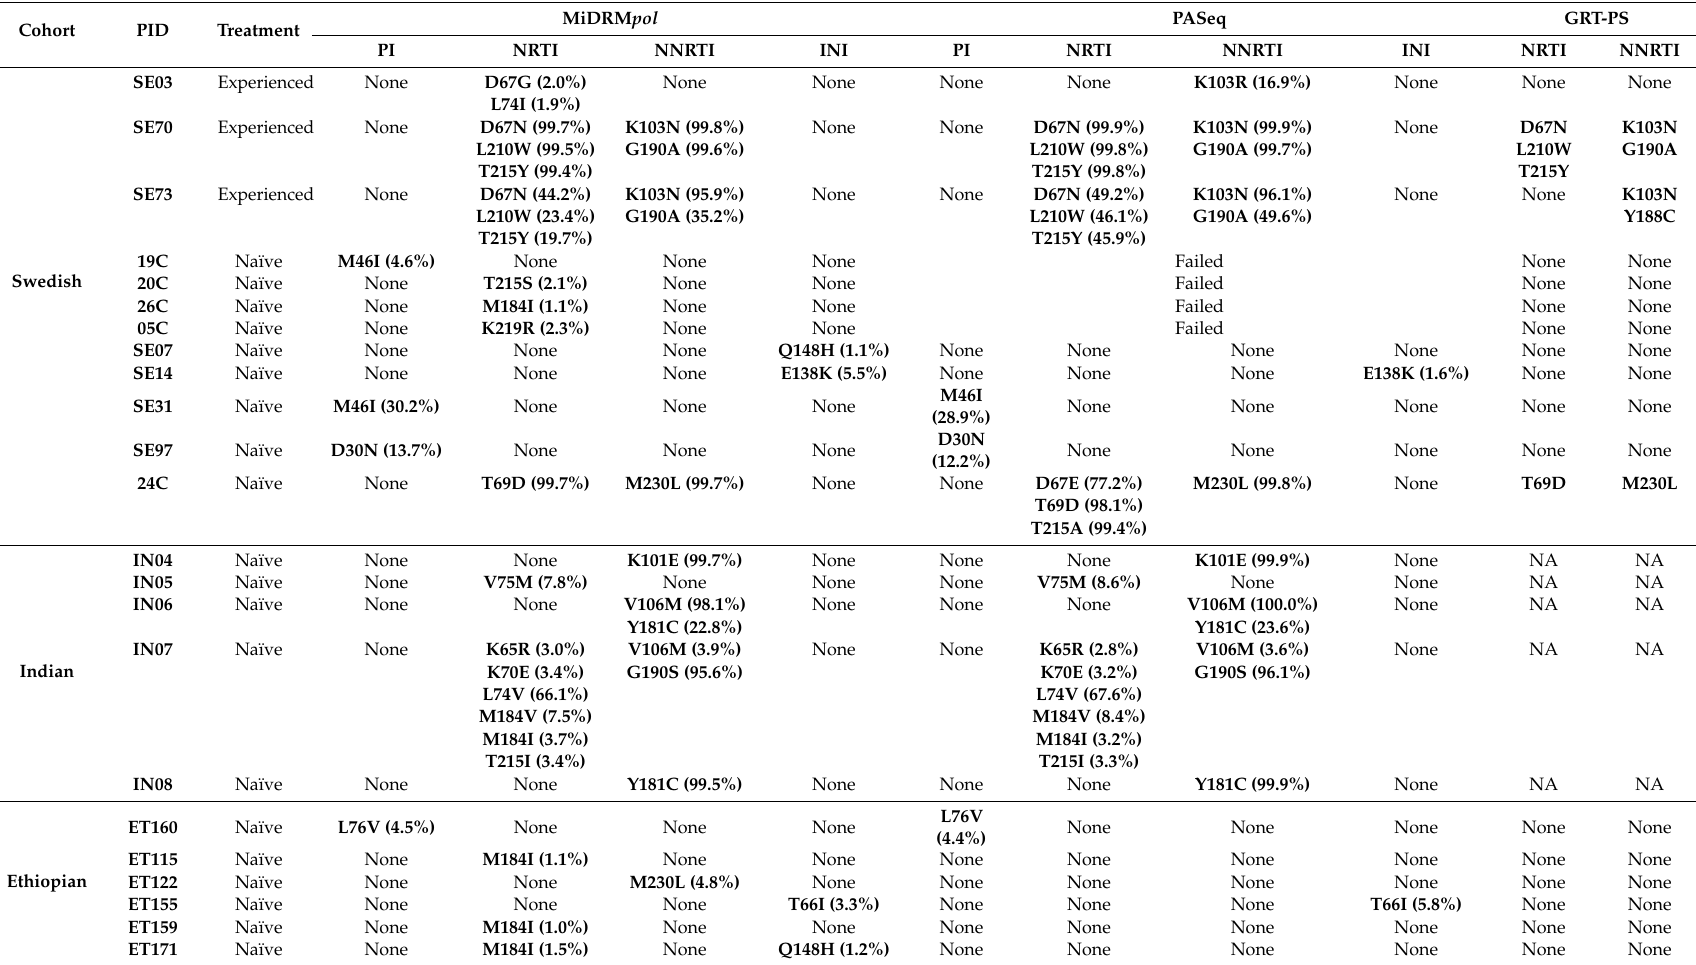
Table 1. Comparison of DRMs identified by high-throughput sequencing or population sequencing as well as in PASeq and MiDRM pol outputs.